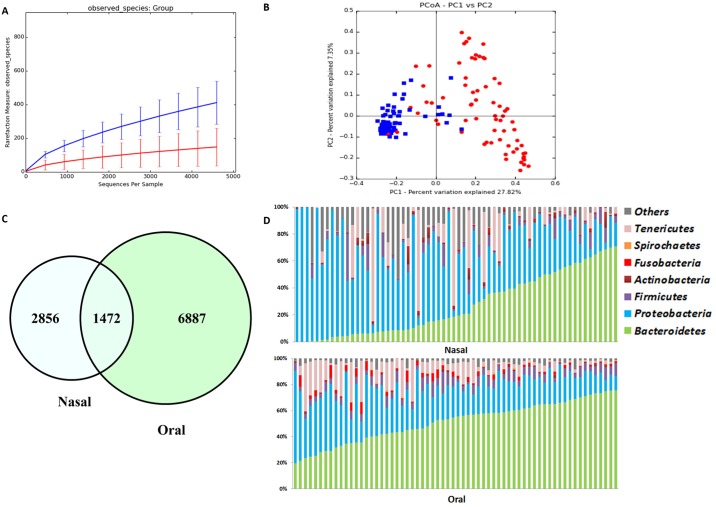
Bacterial diversity measures for all samples from cohort-1.(A) Alpha diversity: rarefaction analysis (number of observed species) of 16S rRNA gene sequences. Lines represent the mean of each group, while the error bars represent the standard deviations. (B) Beta diversity: Principal coordinate analysis (PCoA) of unweighted UniFrac distances of 16S rRNA genes. Analysis of similarity (ANOSIM) revealed clustering between oral and nasal samples (R = 0.6980; P = 0.01). (C) Comparison of OTUs between nasal and oral samples. A Venn diagram showing overlapping OTU’s between nasal and oral samples. (D) Bacterial phyla in nasal versus oral samples. Most common bacterial phyla identified in nasal and oral samples from healthy dogs sorted by the phylum Bacteroidetes.